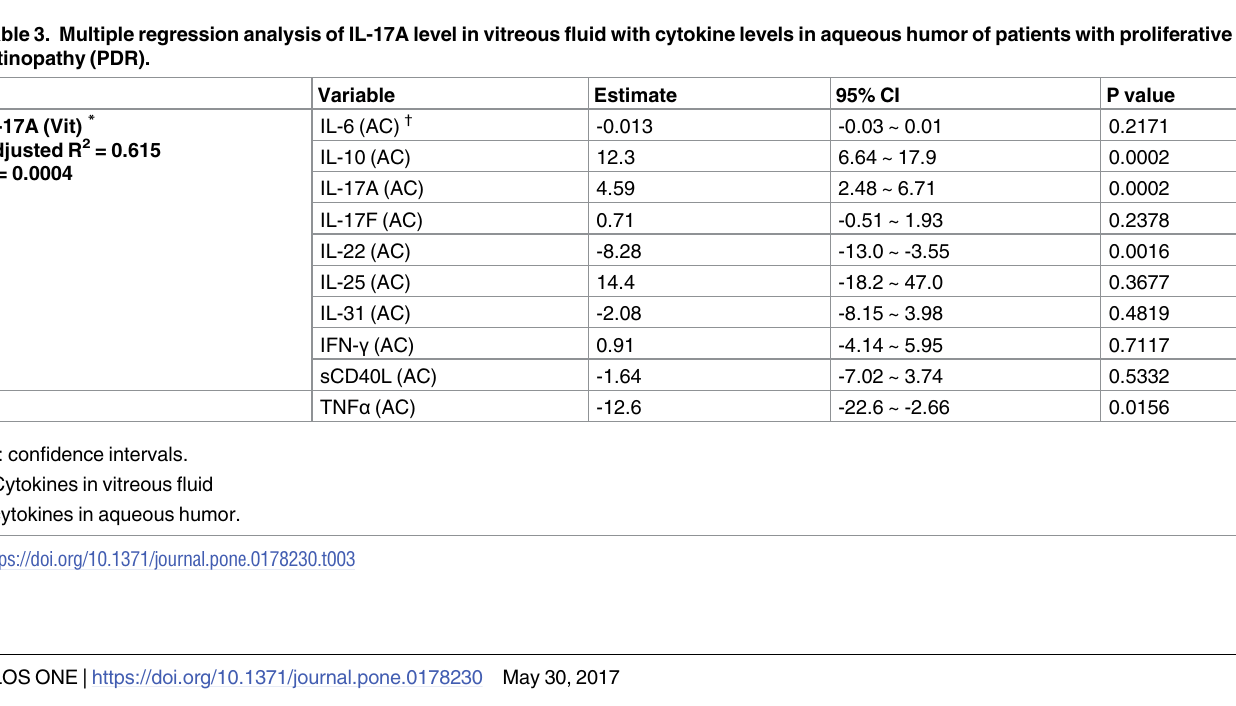
by multiple regression analysis. Vitreous IL-17A level was significantly related to aqueous IL- aqueous IL-17A level was not related to any of the cytokine levels in vitreous fluid (Table 4).